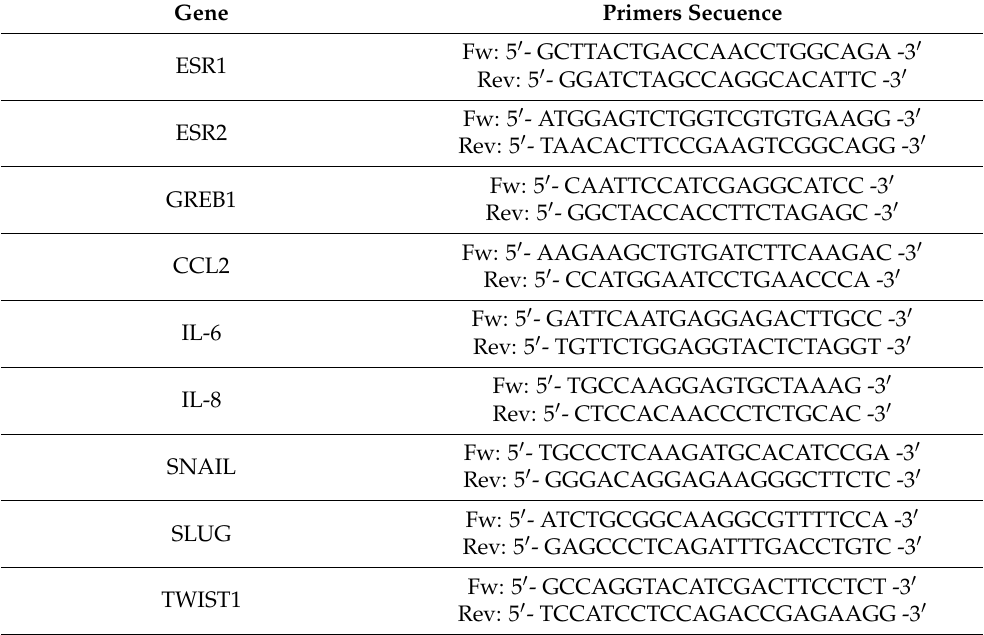
Table 1. Sequence of primers used in PCR